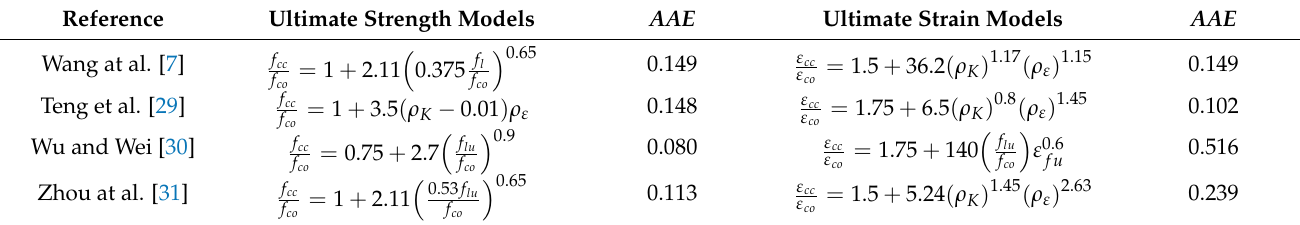
Figure 12. Performance of ultimate condition models. Table 7. Existing models for ultimate